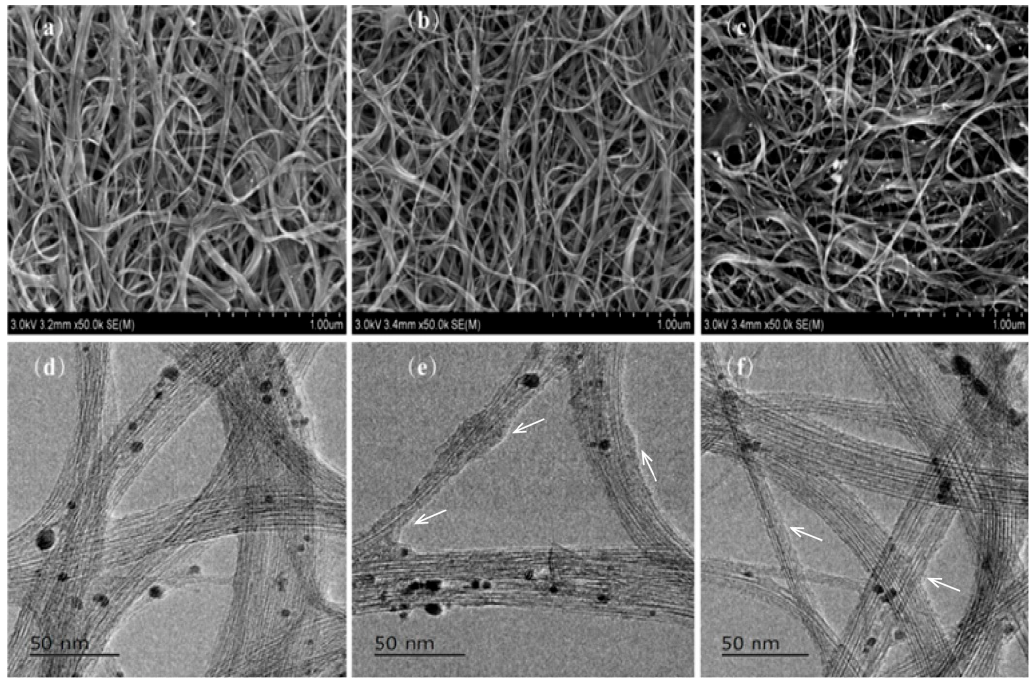
Figure 2. Transmission electron microscope (TEM) and scanning electron microscope (SEM) images of single-walled carbon nanotubes (SWCNTs) doped with different amount of polyethyleneimine (PEI). ( a , d ) 0 wt.%, ( b , e ) 2 wt.%, ( c , f ) 15 wt.%.